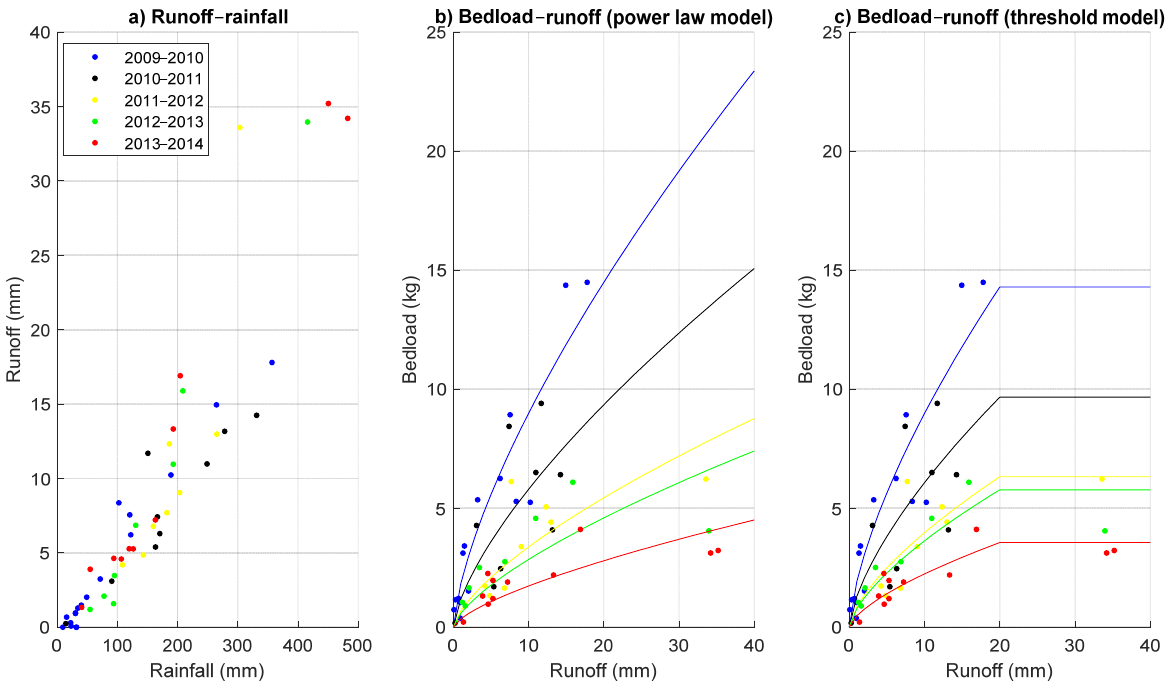
Figure 6. Relationships between the ( a ) runoff and rainfall volumes in the bedload collection periods, ( b ) bedload export and runoff volumes in the bedload collection periods with a fitted power-law model and ( c ) bedload export and runoff volumes in the bedload collection periods with a fitted power-law and threshold model. The data points for the period of 31 January 2011–24 February 2011 (rainfall = 666 mm, runoff = 180 mm, bedload = 10.9 kg) were omitted from all plots to assist with presentation clarity. The power-law model in ( b ) omitted this point from the model fitting, while the power law with the threshold model in ( c ) included this point in the model fitting.